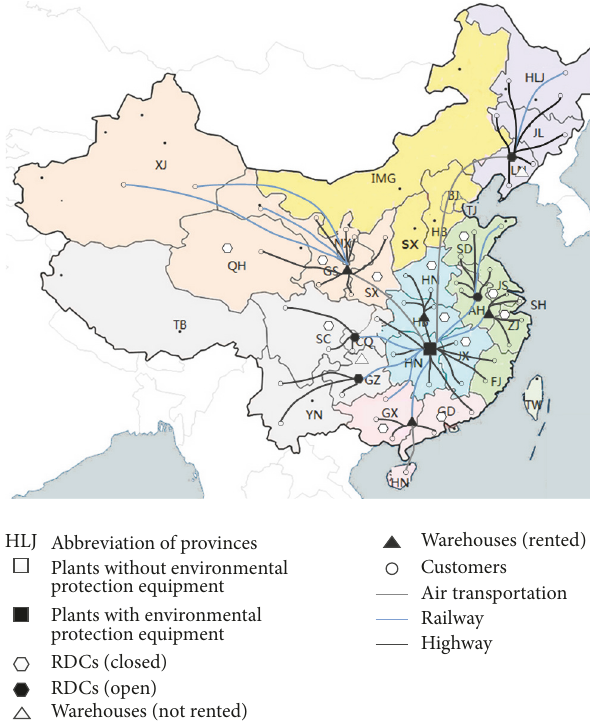
Figure 7: Supply chain network of an electric meter company in China.